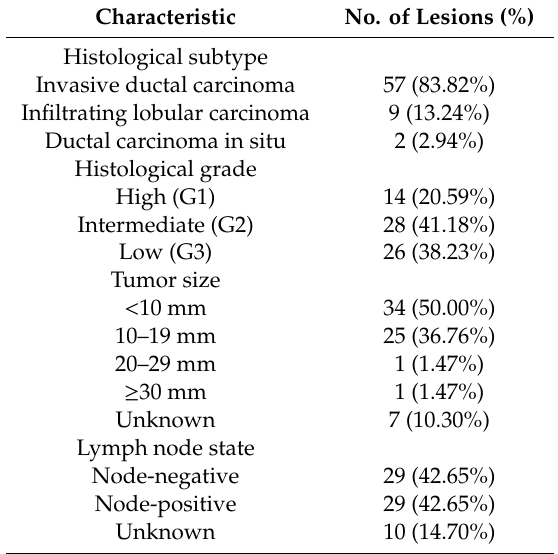
Table 1. Characteristics of the 68 tumors analyzed in the